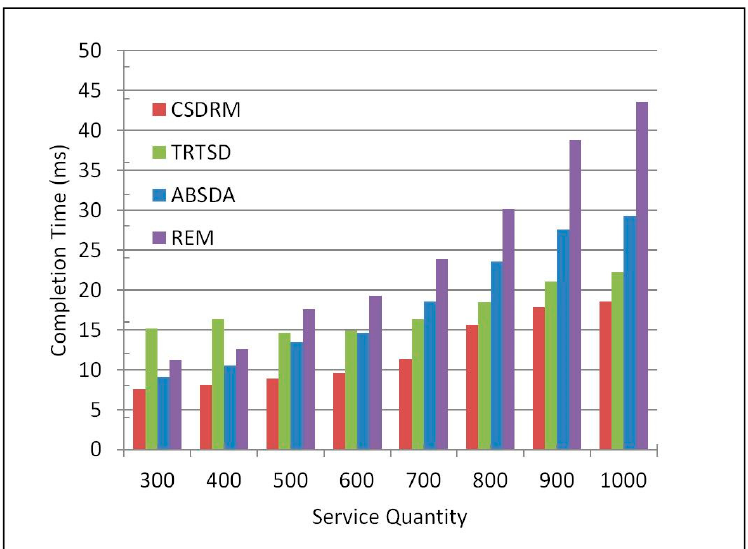
Figure 6. Comparison of efficiency.